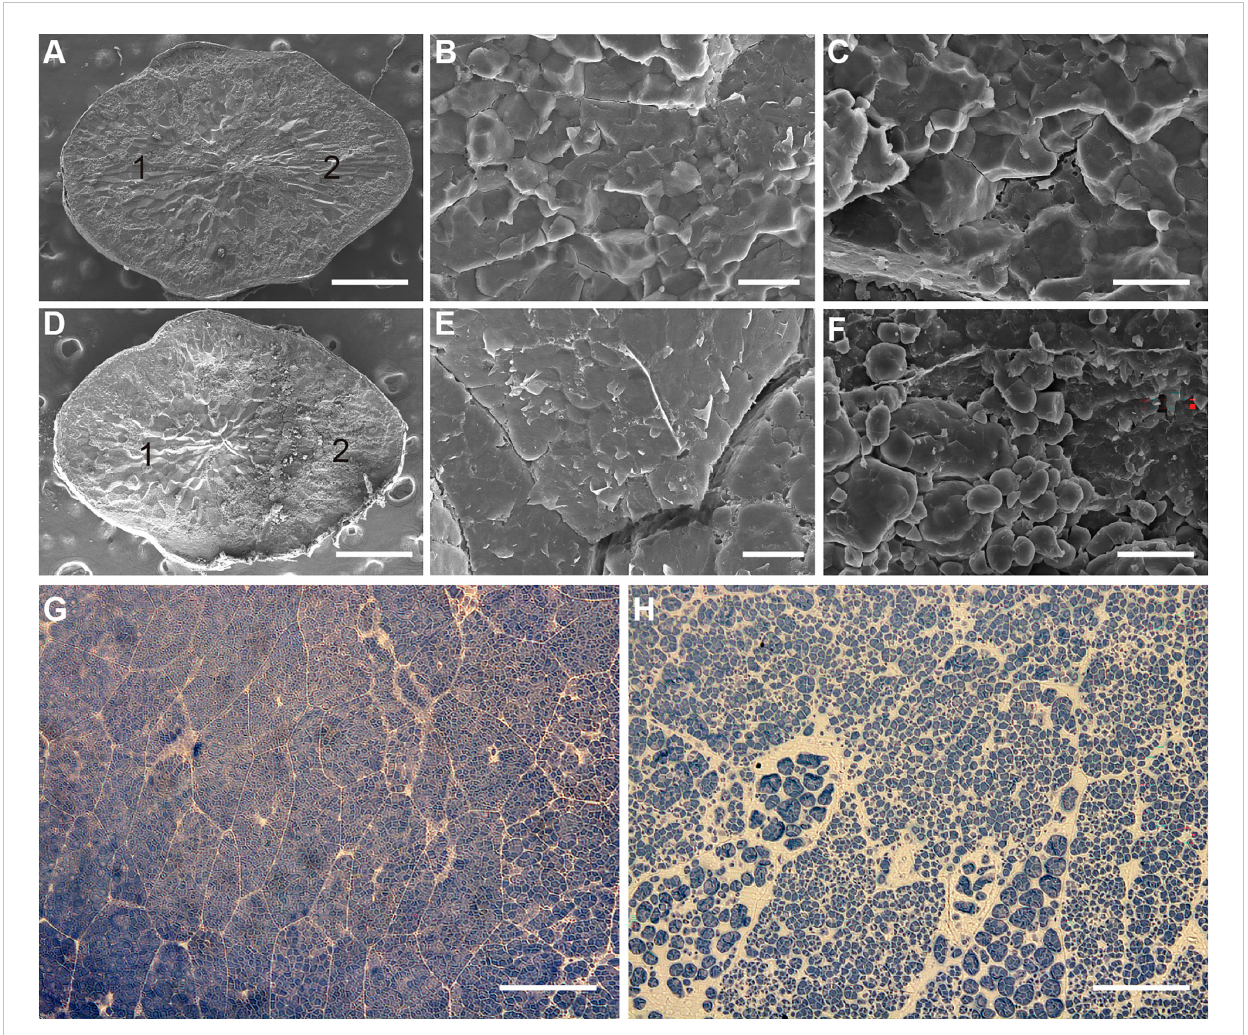
FIGURE 2 wbg1 endosperm morphology. (A – F) Scanning electron micrographs of transverse sections of wild-type (WT) (A – C) and wbg1 (D – F) endosperm. (A, D) Intact endosperm. “ 1 ” and “ 2 ” indicate the dorsal and belly sides of the endosperm, respectively. Scale bars, 0.5 mm. (B, E) Magni fi ed region of the dorsal side of WT and wbg1 endosperm, respectively. Scale bars, 10 m m. (C, F) Magni fi ed region of the belly side of WT and wbg1 endosperm, respectively. Scale bars, 10 m m. (G, H) Semi-thin sections of the belly side of WT and wbg1 endosperm, respectively. Scale bars, 10 m